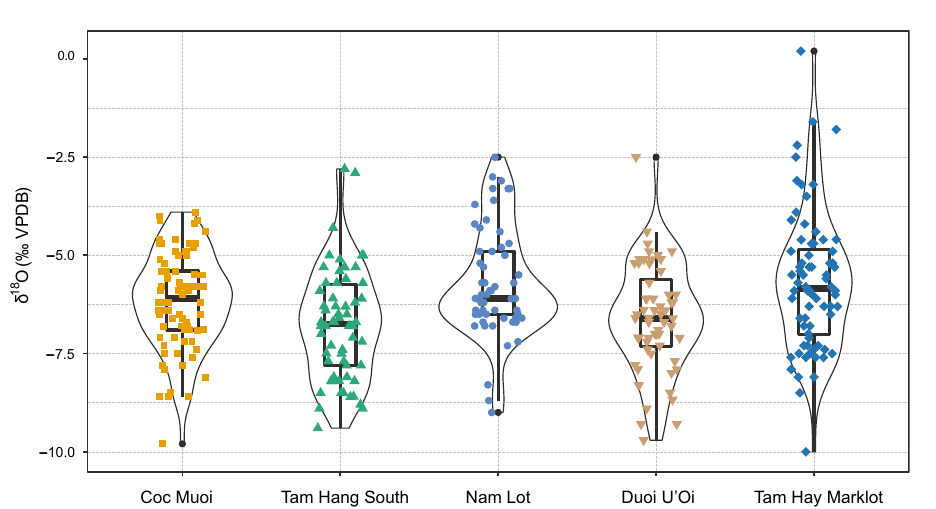
Statistically significant differences between sites, from both the novel (Coc Muoi, Tam Hang South, and Duoi U’Oi) and published data (Nam Lot and Tam Hay Marklot), were determined through Kruskal–Wallis one-way analysis of variance for δ 13 C carbon source (H(4) = 83.3, p-value < 2.2e−16) and for δ 18 O apatite (H(4) = 25.5, p-value = 4.019e−05). Post-hoc Dunn’s test pair-wise comparisons draw out the sites from Vietnam as distinct from the sites in Laos regarding their δ 13 C carbon source values. Tam Hay Marklot and Nam Lot also appear to be sig- nificantly different from each other. Finally, δ 18 O apatite values from Tam Hang South are identified as significantly different from those of all other sites except Duoi U’Oi, while Duoi U’Oi itself is being drawn out as significantly different to Nam Lot and Tam Hay Marklot (Supplementary Tables S8, S9).